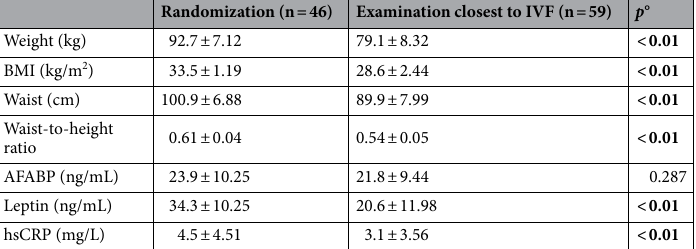
Table 4. Effects of weight loss intervention. Significant values are in [bold]. Values are mean ± SD or percentage. °Related-Samples Wilcoxon Signed Rank test, intervention group at randomization versus examination closest to